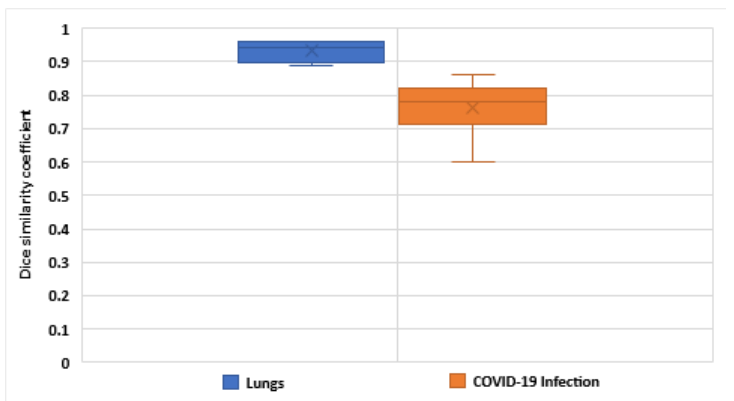
Figure 9. The result distribution of the five-fold cross-validation is presented using box plots for lung and infected region segmentation.